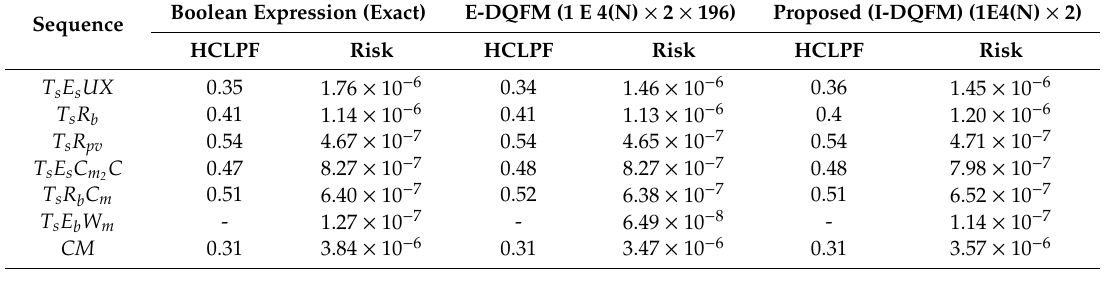
Table 5. Mean seismic risk for “LGS NPP”: Fully correlated case.